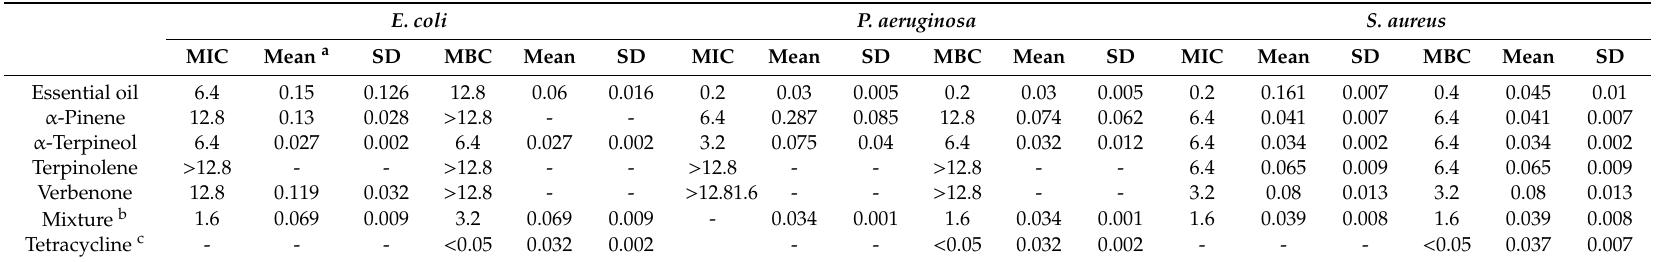
Table A2. Antibacterial activities of SEO and the major monomers.